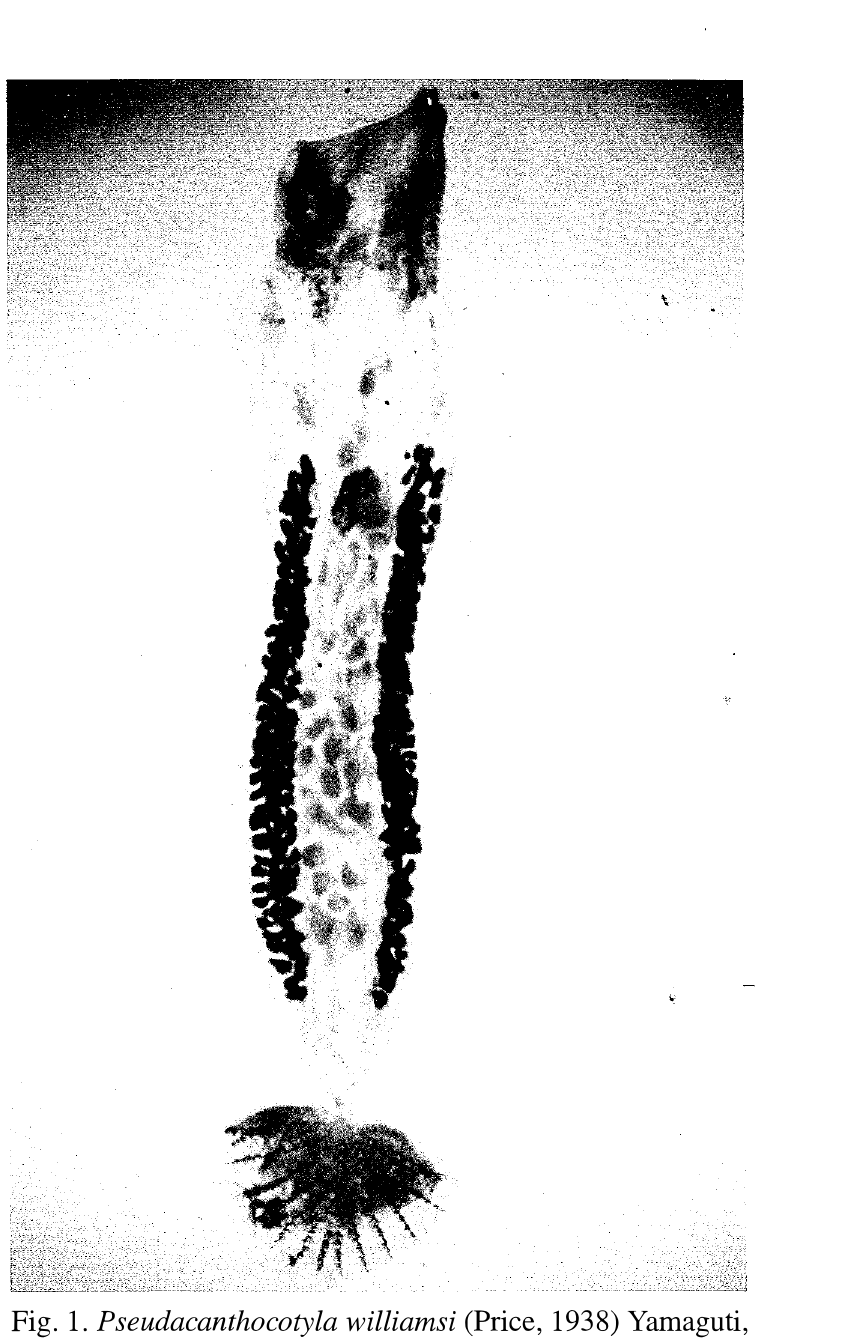
Fig. 1. Pseudacanthocotyla williamsi (Price, 1938) Yamaguti, 1963 from the gills of Greenland halibut, Reinhardtius hippoglossoides (Walbaum, 1792); entire specimen, wentral